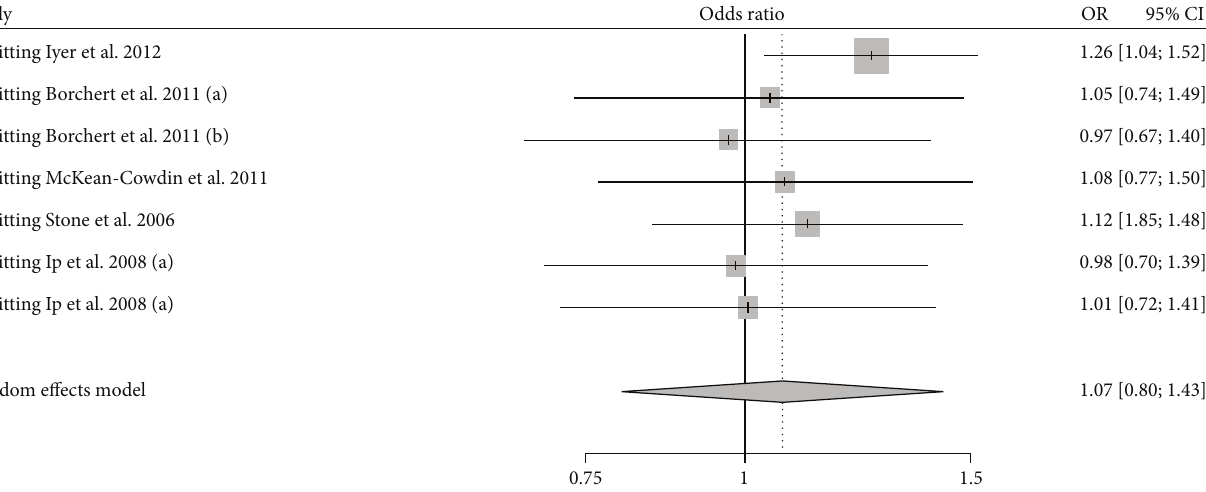
Figure 3: Sensitivity analyses for the influence of each study involving refractive error on the overall